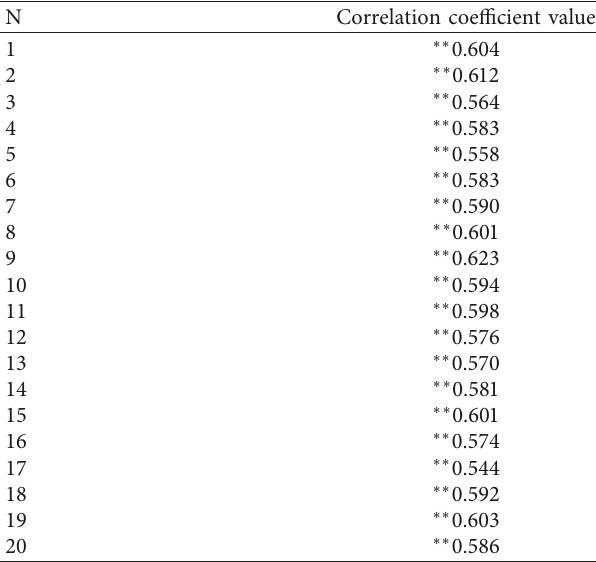
Table 1: Correlation coefficients between the score of each item of the psychological flow scale and the overall score of the